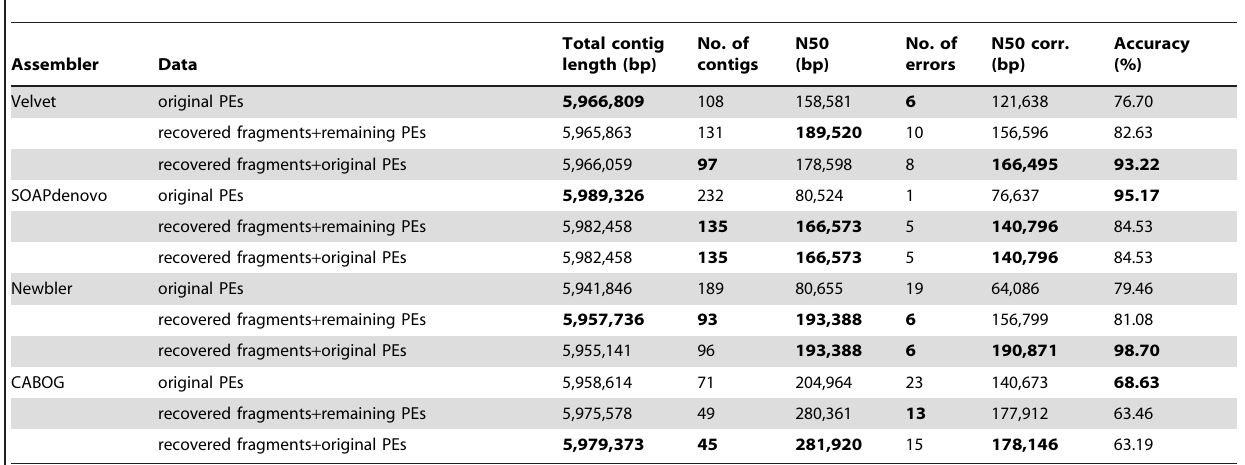
Table 7. Statistics of P. brasiliensis assemblies by four assemblers on three types of real